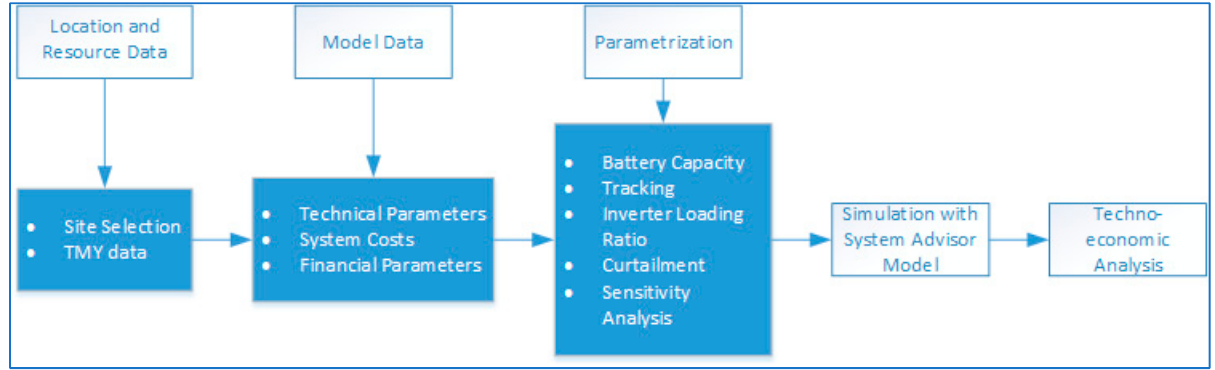
Figure 1. The analytical framework for this study.